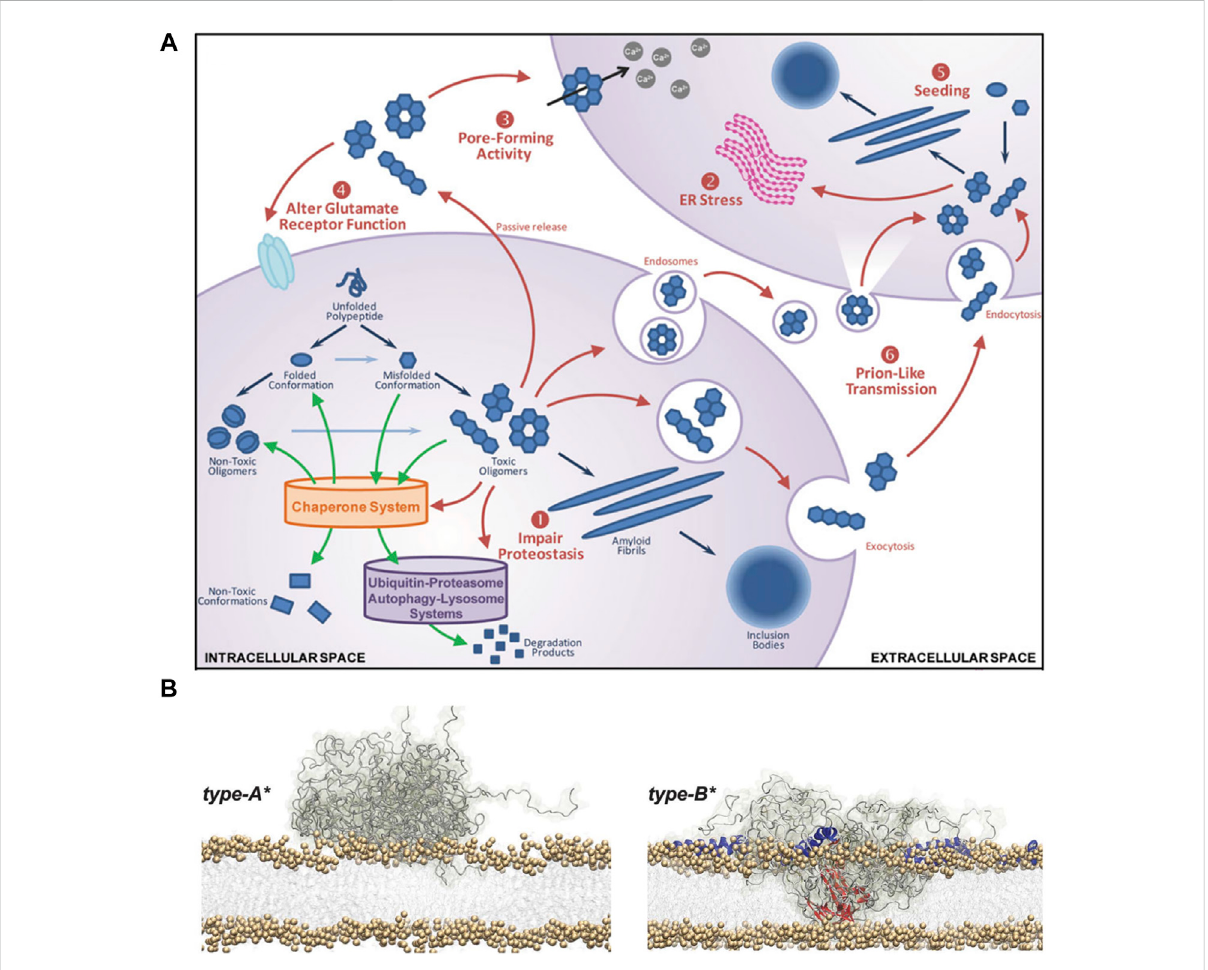
FIGURE 1 Toxic effects of α SNoligomers. (A) Schematicrepresentation ofthe α SNoligomerization andensuing toxicity. The outlined process includes: 1) impaired proteostasis, 2) prolonged ER stress, 3) aberrant pore formation, 4) dysfunctional glutamate receptor, and 5) intracellular uptake and seedingfollowedby6)neuron-to-neurontransmissionofpathologicalaggregates(Kaliaetal.,2013). (B) Schematicrepresentationofthemembrane destabilization process by two types of oligomers with distinct secondary structure contents. Type-A* oligomers are predominantly unstructured and can only bind to the surface of biological membranes (left). Type-B* oligomers exhibit both disordered (gray) and β -sheet (red) regions where the β -sheet regions penetrate through the lipid bilayers, provoking destabilization (right). In addition, the folding of the N-terminal regions into α -helices (blue) provide more binding regions to the membrane (Fusco et al.,